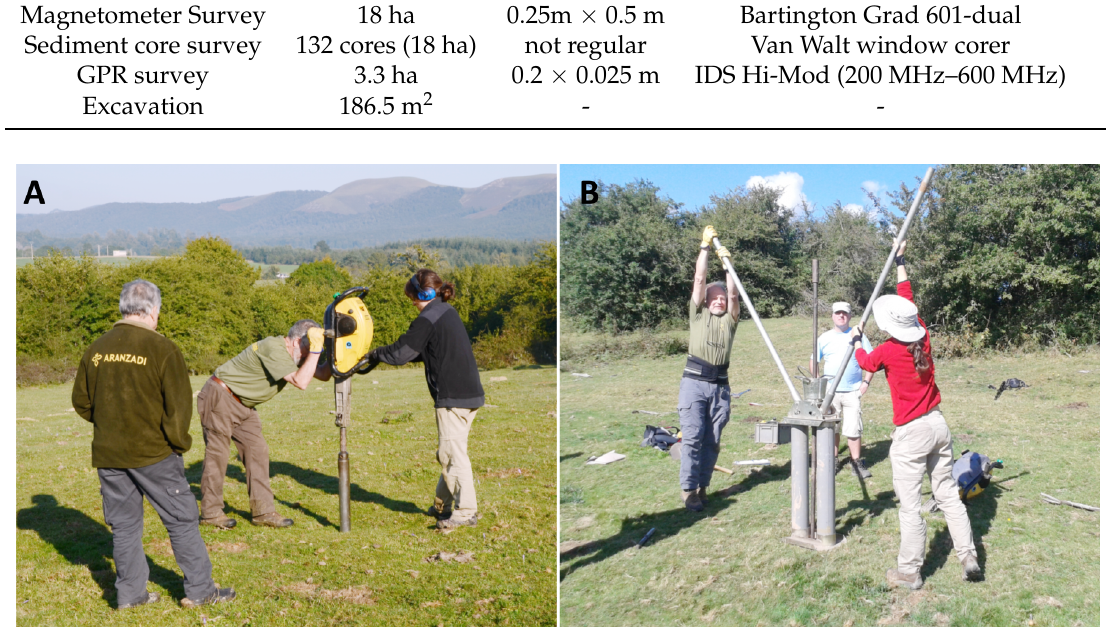
Figure 2. ( A ) Photograph of the power auger (Cobra TT engine) used for drilling; ( B ) Photograph of ARANZADI and MOLA team removing the gouge